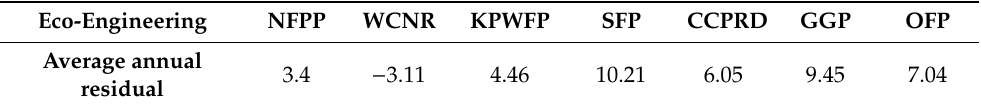
Table 5. Average residuals of the di ff erent ecological engineering projects during 2000–2018 on the Guizhou Plateau.